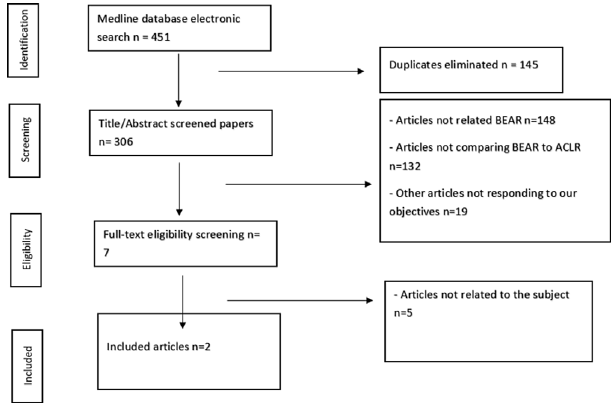
Figure 1. PRISMA fl owchart for article selection process.